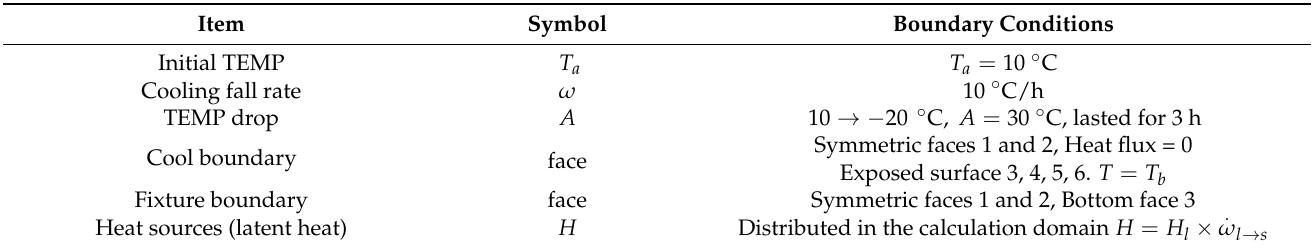
Table 2. Boundary conditions of temperature field analysis.